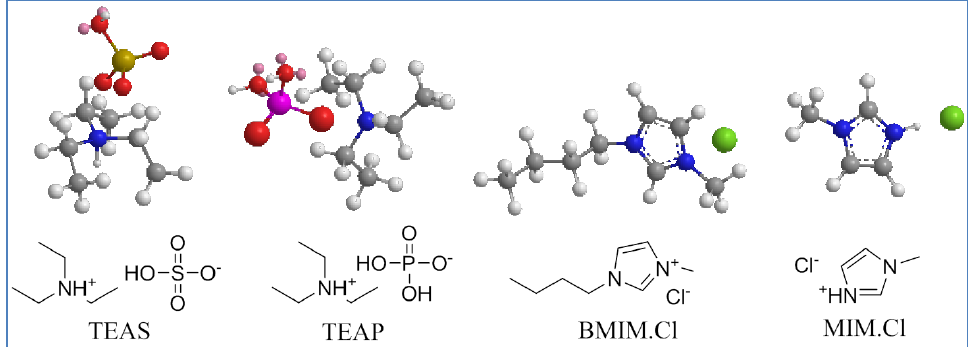
Figure 1. Structure of ammonium and imidazolium ILs. Brown, white, red, blue, pink, golden and green colored balls represent carbon, hydrogen, oxygen, nitrogen, phosphorus, sulphur and chlorine atoms, respectively. Small pink balls represent the lone pairs on oxygen atoms.